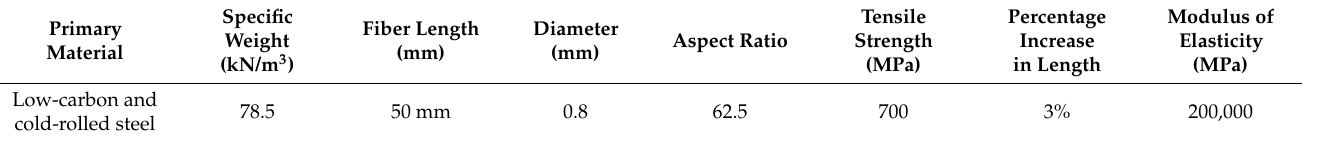
Table 4. Mixing design details (in kg/m 3 ).